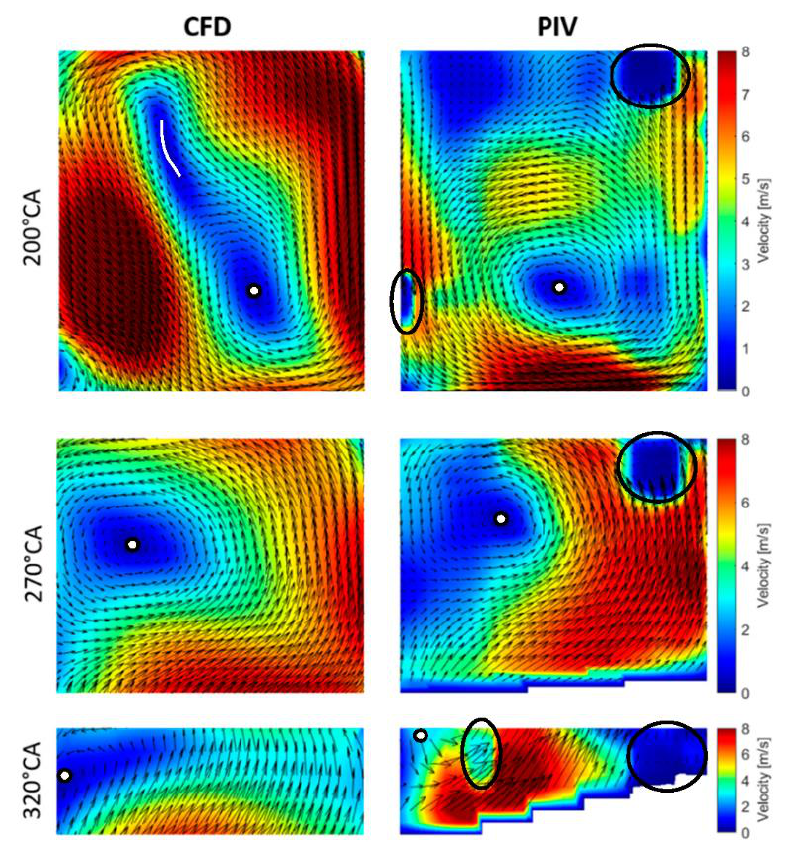
Figure 11. Mean flow velocity fields: simulation ( left ) and experiment ( right ) VVT in/ex = 30/30. For all of the angular positions, the order of magnitude of the measured vs. simulated velocities is the